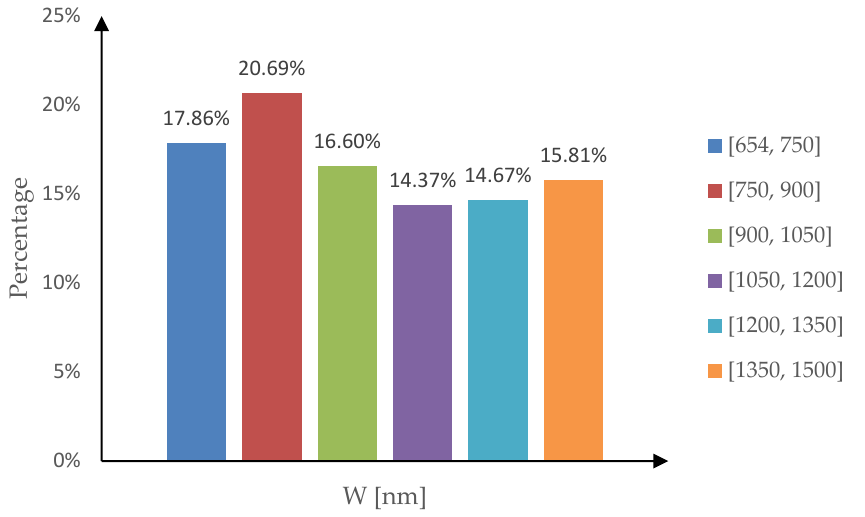
Figure 8. Gate width distribution of the test data with an RE greater than µ + 3 σ . The test data with an RE greater than µ + 3 σ accounted for 1.50% of all test data.